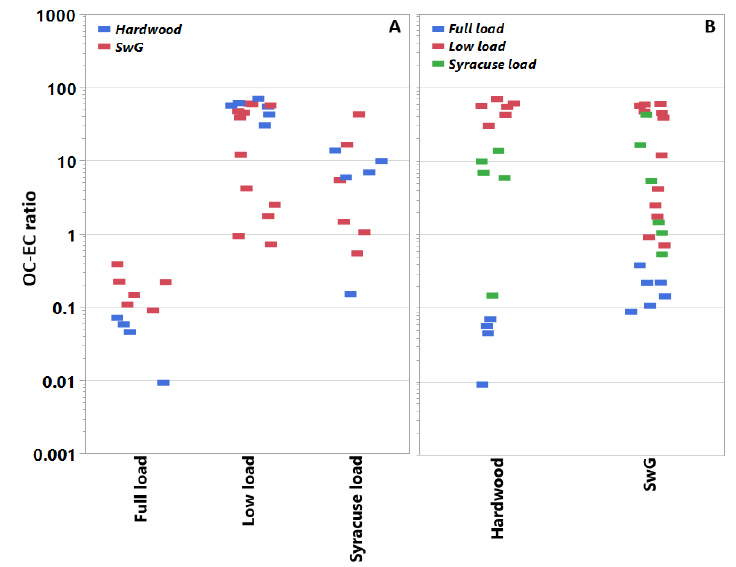
Figure 2. Filter-based OC–EC ratios in PM for individual tests sorted by heat load demand profile and fuel type. Panel A pools the OC–EC ratios by fuel type, whereas panel B pools them by operational mode. Data populations: Full load ( n = 10), low load ( n = 18), and Syracuse load ( n = 11).